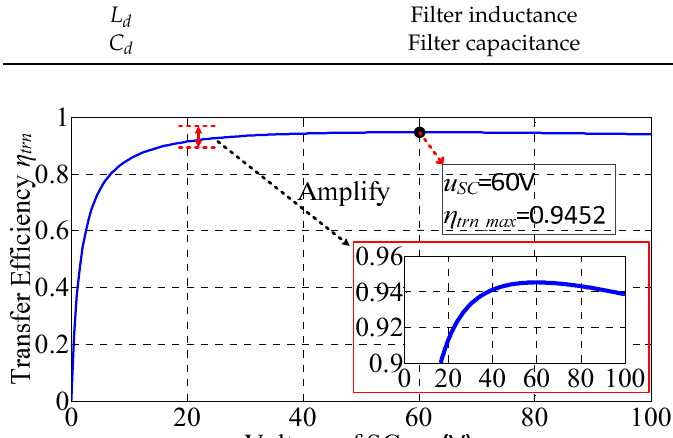
Figure 5. Curve of the maximum efficiency vs. T Q .